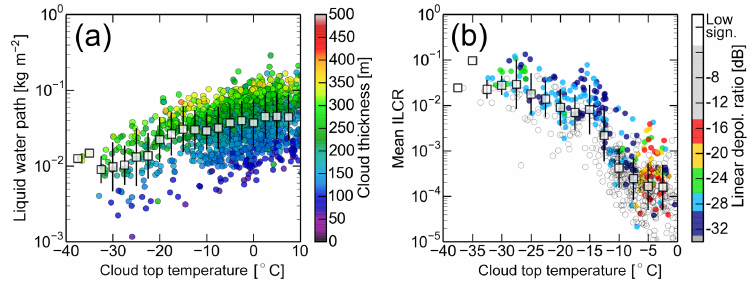
Figure 9. (a) LWP of all clouds under study is shown in dependence of temperature and mean cloud-top thickness. (b) The ratio between IWC CB and mean LWC is calculated for each cloud profile and averaged for each cloud case.